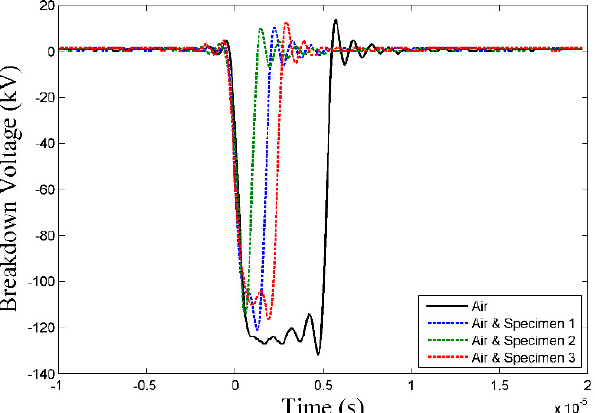
Figure 15. Lightning impulse discharge waveforms for air alone as well as its combination with open cell foam specimens of Table 4 at 51.4 psi.